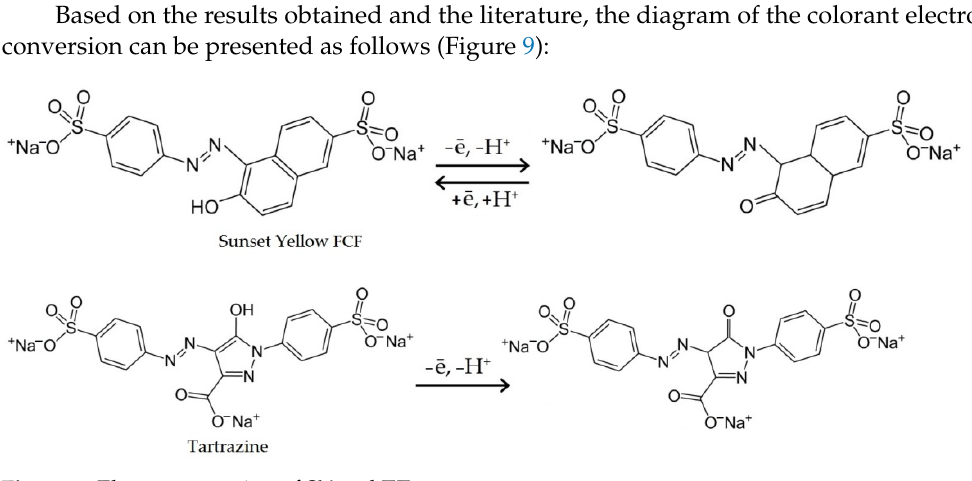
Figure 9. Electroconversion of SY and